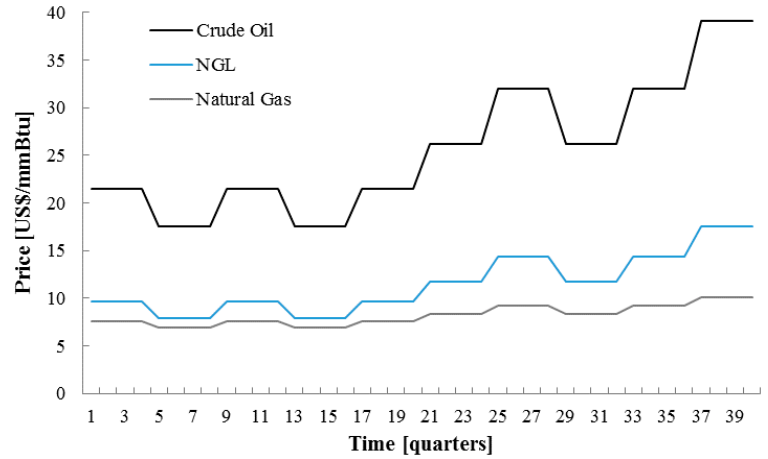
Figure 8. Variation of crude oil, NGL, and natural gas prices during the planning horizon.